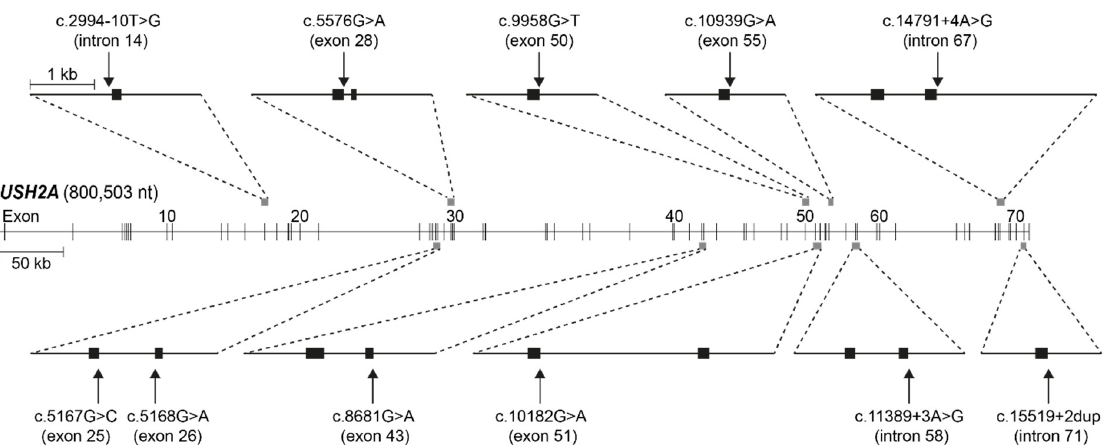
Figure 1. Visual representation of USH2A (NM_206933.2) and its exons with the location of the 11 tested variants and ten minigene constructs that were generated. Exons are represented by black blocks. kb: kilobases, nt: nucleotides.